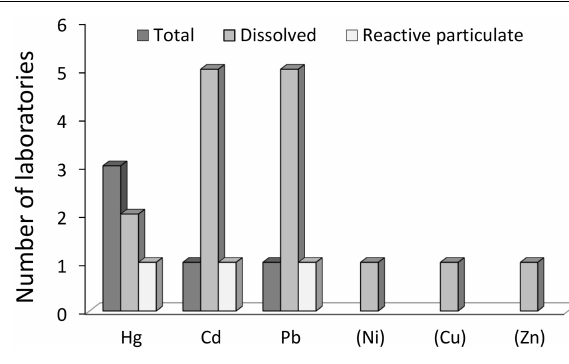
FIGURE 2 | Sample types for metal analysis in seawater (one laboratory analyzed two sample